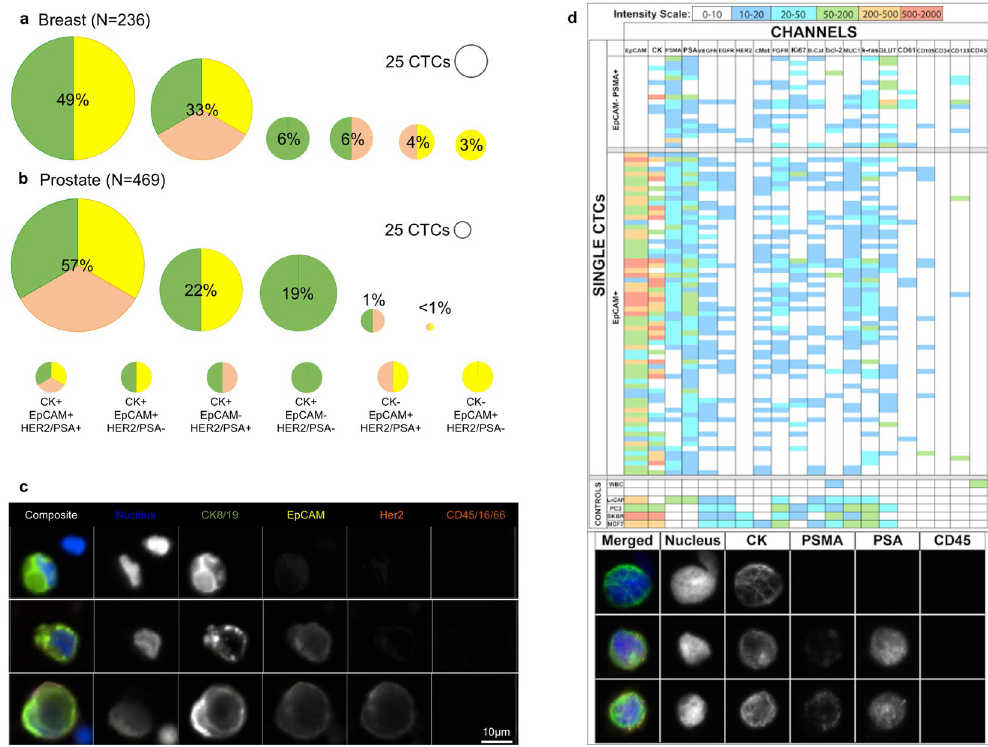
Figure 3. Heterogeneity of Cells Collected – Proportions of collected CTCs in different bins based upon positivity of surface and intracellular markers from ( a ) breast cancer patients and ( b ) prostate cancer patients. ( c ) Example images of CTCs from a single breast cancer patient. ( d ) Top panel: Table view of single CTCs identified via their positivity for PSMA and/or EpCAM (top rows) and control cell lines or white blood cells (bottom rows, represents median). Each row represents a single nucleated event and each column represent a channel detecting specified antigen. Color scale is denoted in the bottom, with white representing signal below S/N threshold set based upon controls. Bottom panel: a parallel slide based analysis of the same sample confirmed positive cells and their immunostaining for tumor marker. We detected 45 CTCs from slide-based analysis and 86 from mass cytometry based analysis from a total of 12 mL blood. (CK: cytokeratin, PSMA: prostate specific membrane antigen, PSA: prostate specific